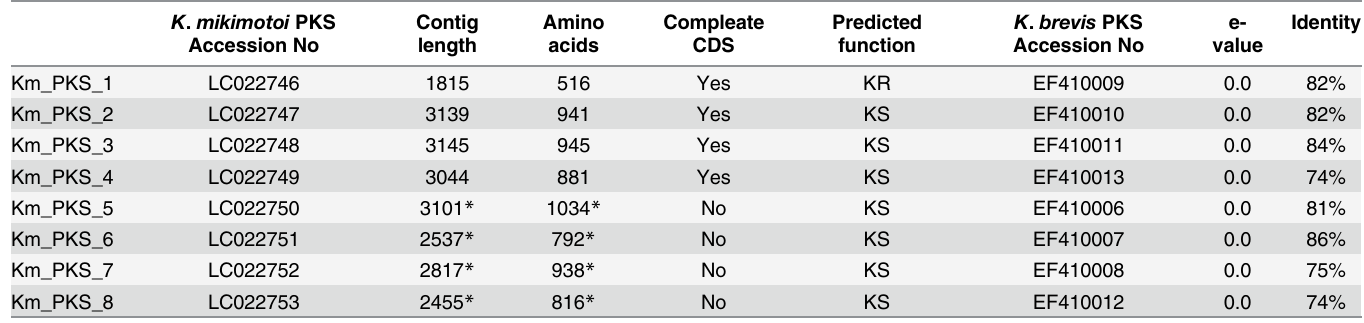
Table 5. Summary of PKS genes in Karenia mikimotoi